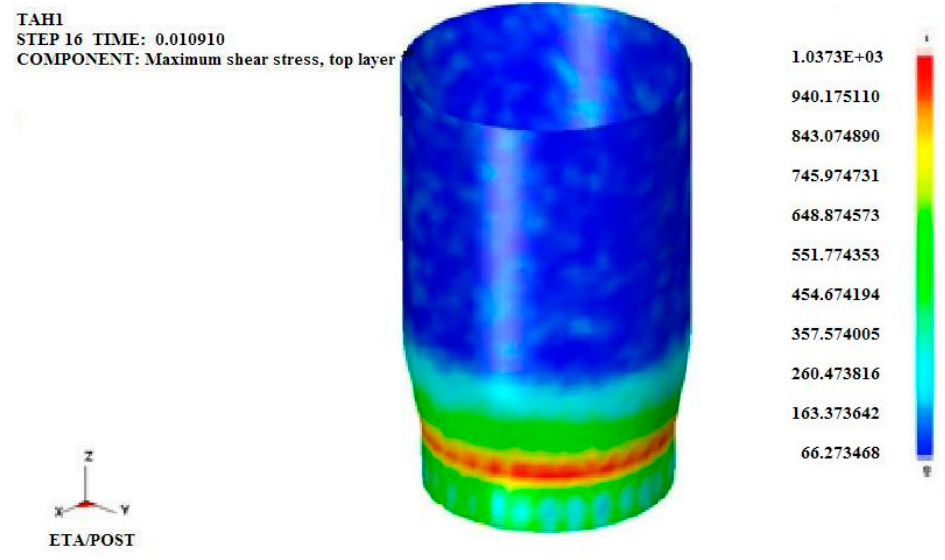
Figure 12. Stress in the formed material after the first draw σ = 1 037 MPa.